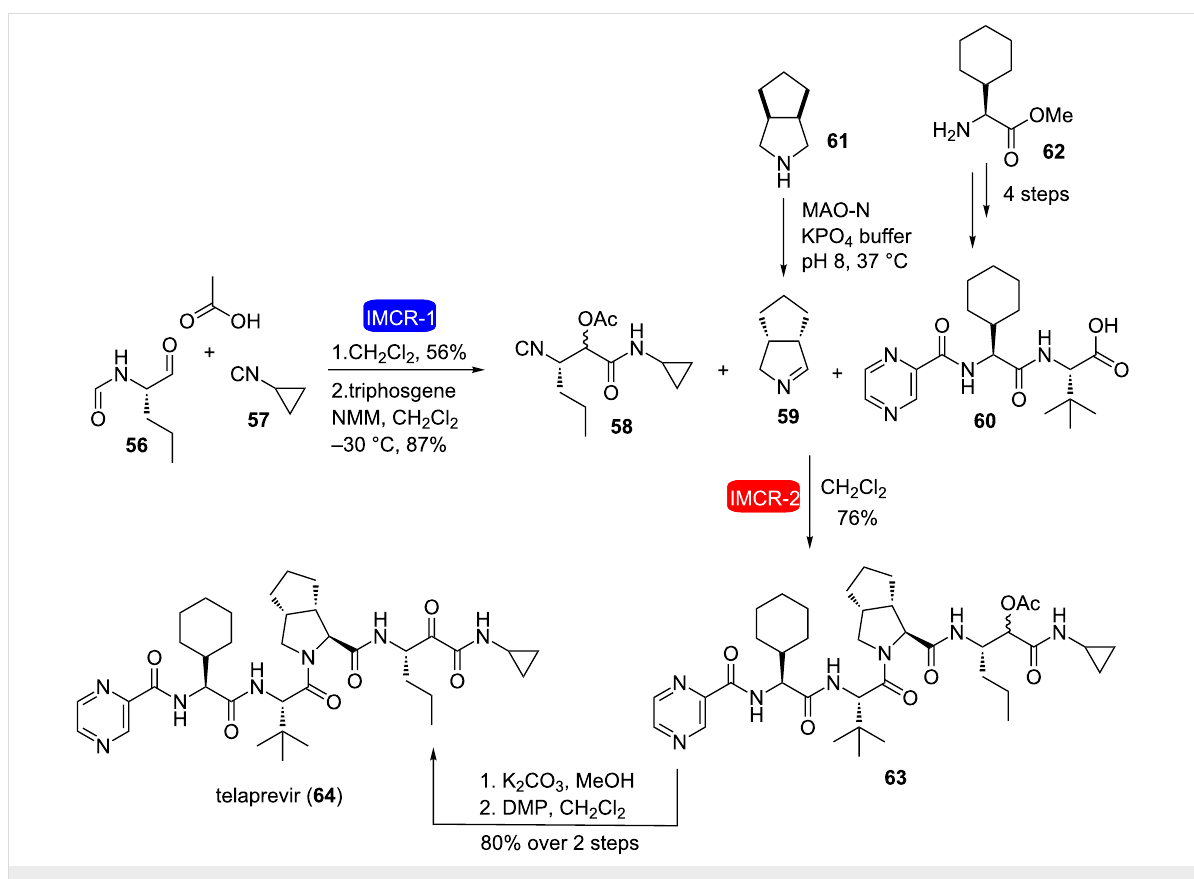
Scheme 12: Synthesis of telaprevir through consecutive IMCRs [28].